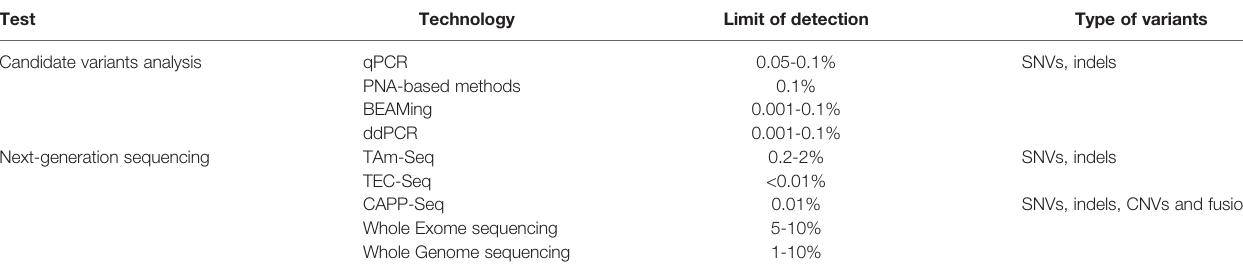
TABLE 1 | A summary of methods for detection of genetic alterations in cfDNA and their performances.